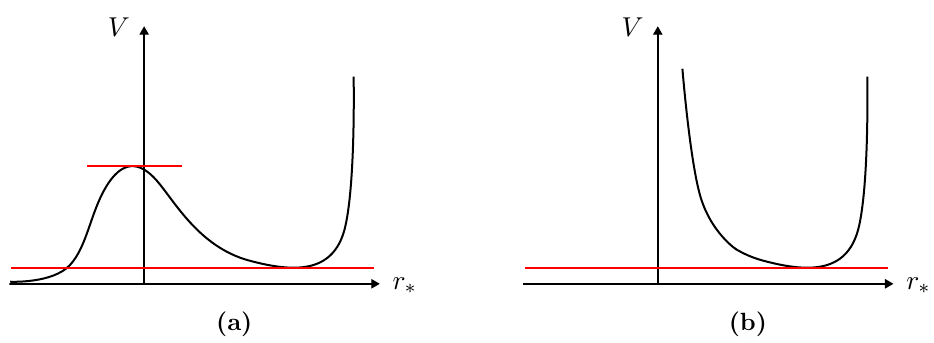
Figure 3. Depiction of the e(cid:11)ective Schr(cid:127)odinger potential in (a) Schwarzschild-AdS, and (b) Global AdS. The lower red line corresponds to the global minimum in pure AdS whereas the upper red line in (a) corresponds to the local maximum of the angular momentum